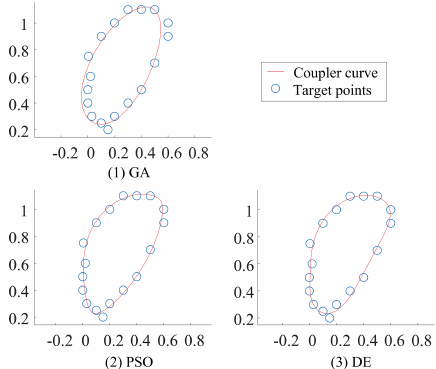
Figure 7. Coupler curves obtained in this study for Example 1.